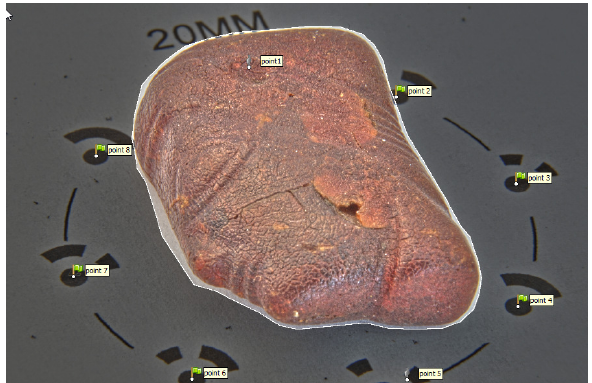
Figure 2. Photographing of the ancient amber figurine. The calibration plate has eight binary coded photogrammetric signals. During the reconstruction of 3D-model the software recognises the binary-coded signals, measures them and records the image coordinates of them at every image where they are visible. The 3D-reconstruction was done by dividing images into two groups, one per each side. On that way, we could use the control points at each side.